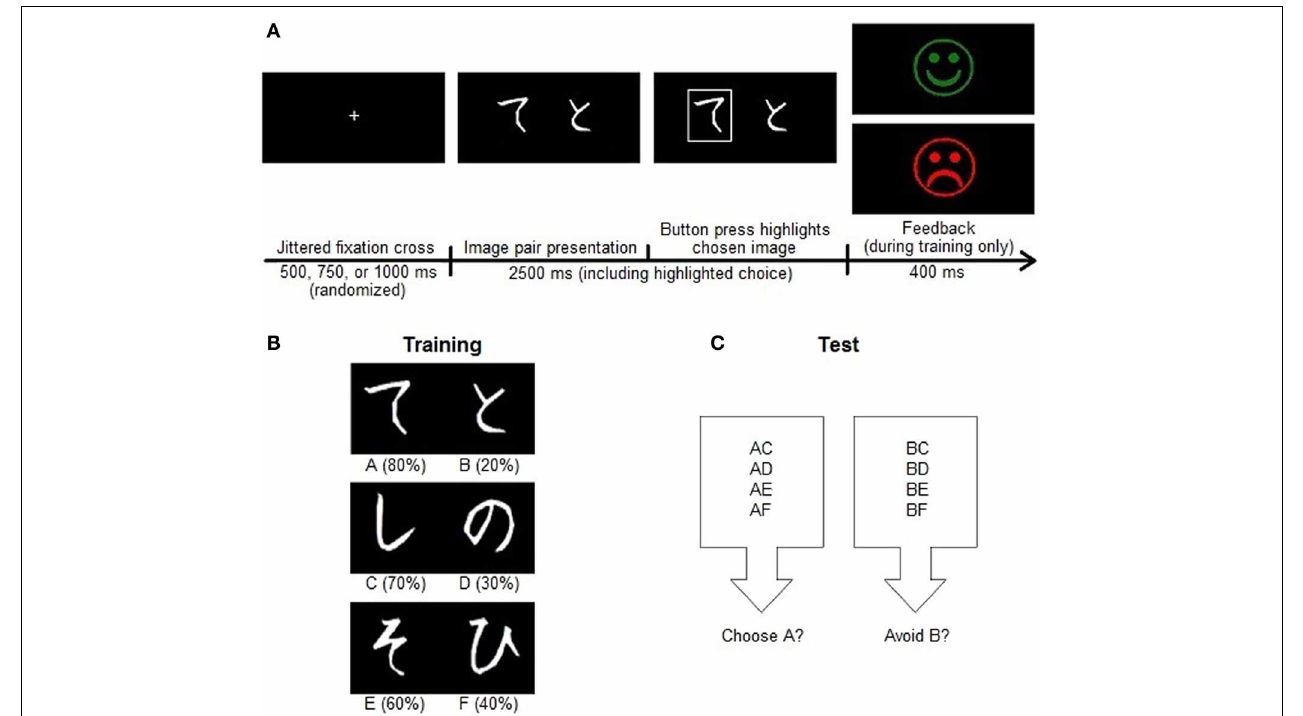
FIGURE 2 | Probabilistic selection (PS) task. (A) Each trial in the PS task began with a jittered fixation cross followed by a pair of stimuli for 2500ms. Following a left or right button response, the selected image appeared highlighted on the screen for the duration of the 2500ms presentation. Choices during training then received probabilistic feedback, whereas those during testing were followed by the fixation cross marking the next trial. (B) In the training phase, participants learned to choose between three discrete pairs of Japanese Hiragana characters with different reward contingencies.